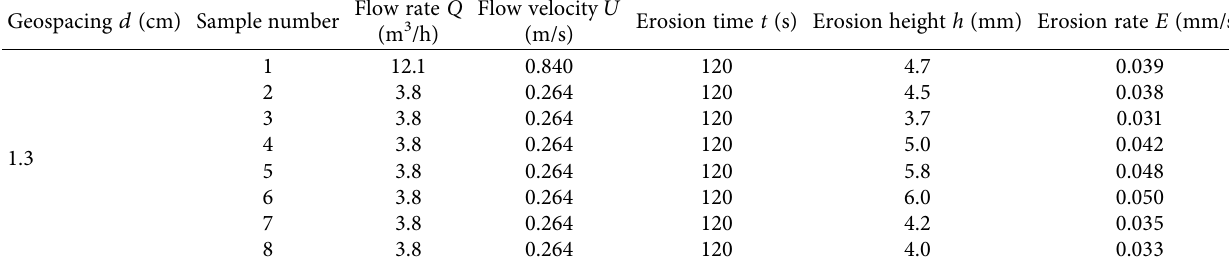
Table 4: Experimental data of tailings erosion with the reinforcement spacing of